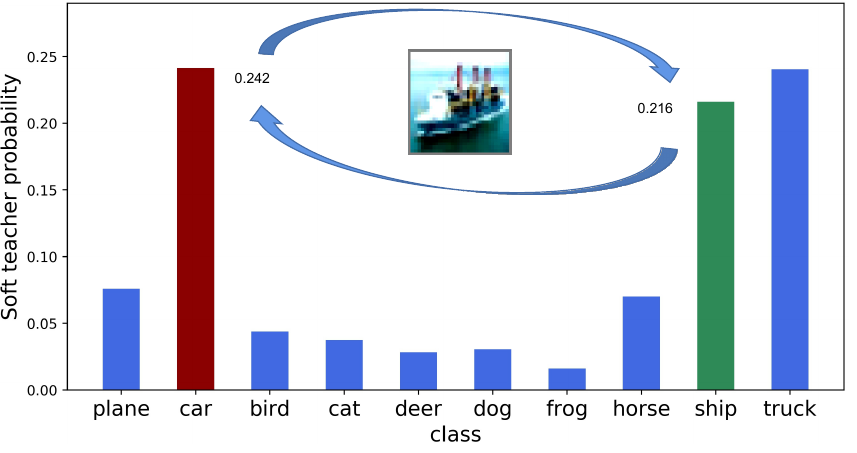
Figure 5. Knowledge Adjustment of a wrong probability offered by an imperfect teacher. The distri- bution is from a sample of the CIFAR-10 training dataset, whose ground truth label is ‘ship’, but the teacher’s prediction is ‘car’. Their values are